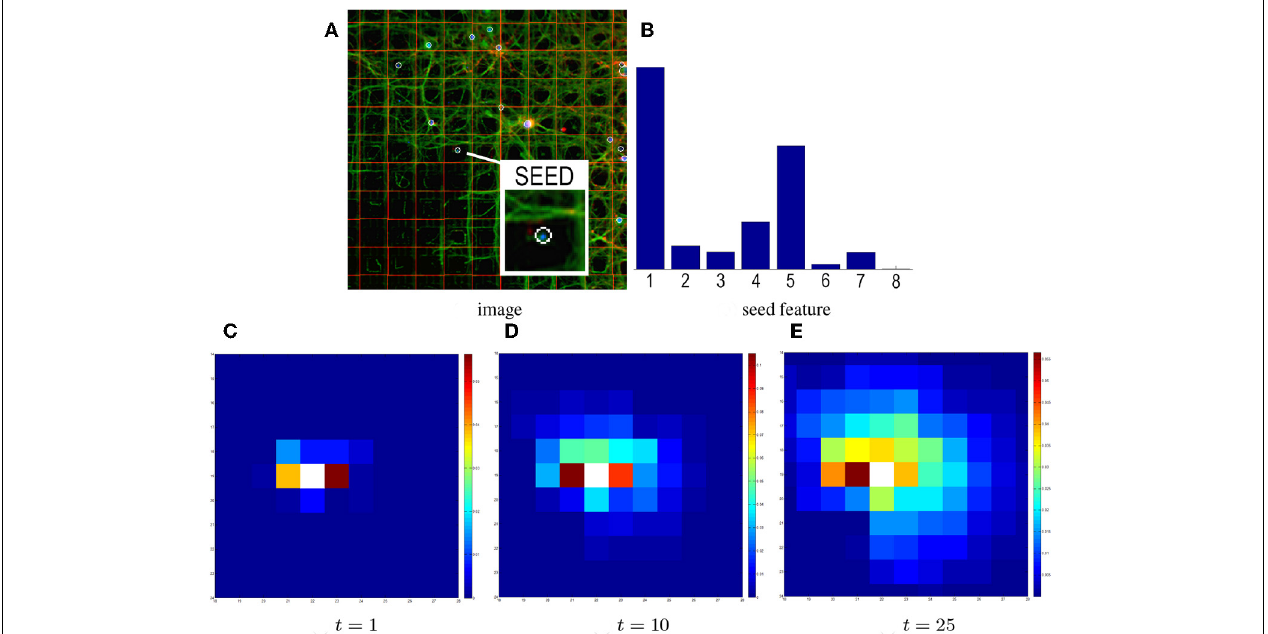
FIGURE 4 | Influence of time on heat propagation. The heat propagation time directly influences the estimated connectivity. (A) The input image and seed electrode. (B) The corresponding probabilistic directional feature. Higher histogram values in bins #1 and #5 reflect the structure of neurites in the patch (spreading horizontally). (C) Result of the GHK propagation at time